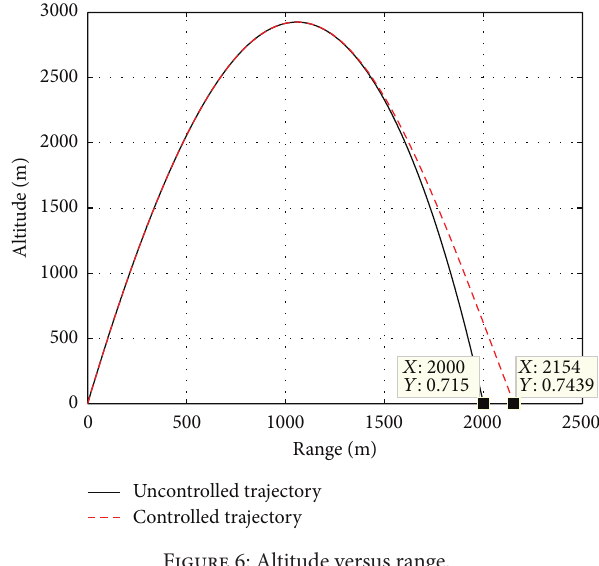
Figure 4: Roll rate versus time.